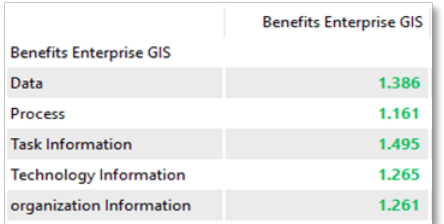
Figure 8. Collinearity Statistics value